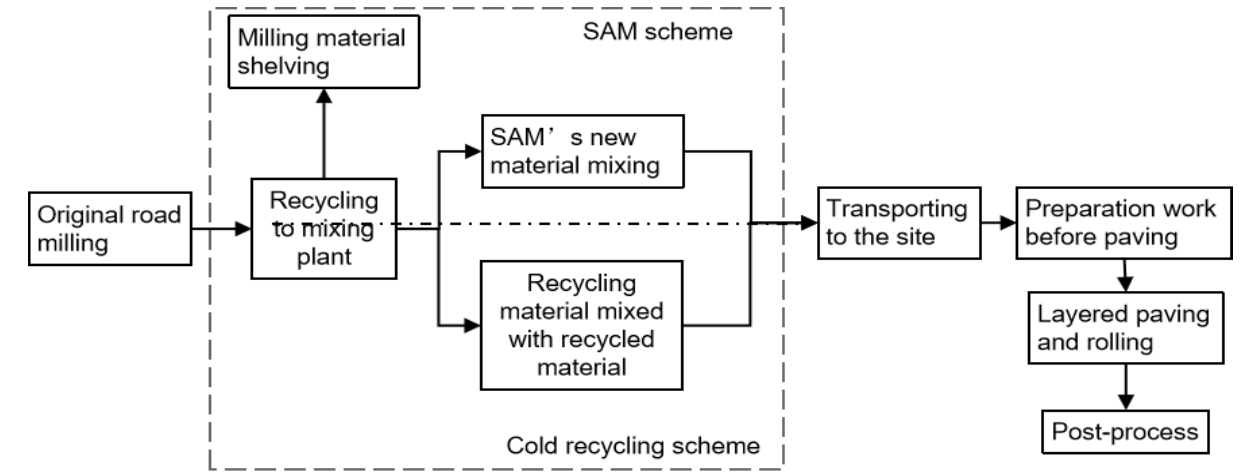
Figure 2. Construction technique of asphalt pavement maintenance technology.